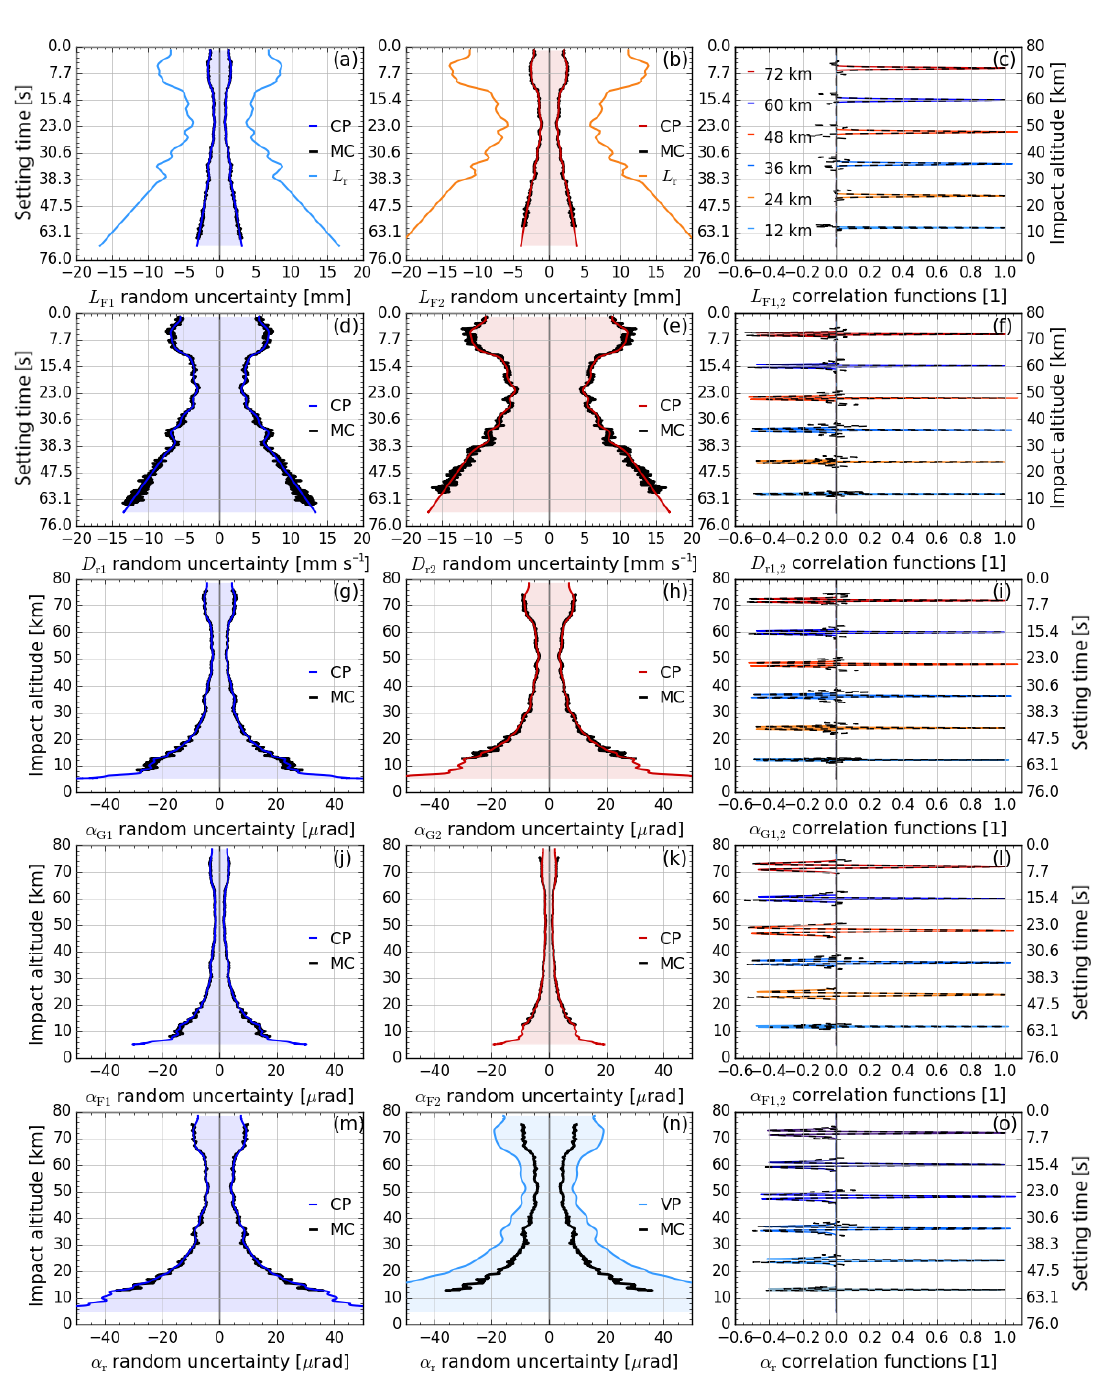
Figure 9. Results from the validation of CP covariance matrices C CP (“CP”) by MC covariance matrices C MC (“MC”) (first four rows): the L r L r consecutive retrieval steps are shown for L F ( a–c ; in panels a–b also for L r ) and D r (d–f) relative to setting time t , and for α G (g–i) and α F (j–l) relative to impact altitude z a . The left column shows estimated random uncertainties for f T1 (CP in blue, MC in black, in panel a u r in light blue); the middle column for f T2 (CP in red, MC in black, in panel b u r in orange); the right column representative correlation L r1 L r2 functions at 60, 36, and 12km for f T1 (CP in blue, MC in black) and 72, 48, and 24km for f T2 (CP in red, MC in black). The last row (m–o) shows CP (blue) and MC (black) results for estimated α r random uncertainties (m) and representative correlation functions at 72, 60, 48, 36, 24, and 13km (o) , as well as variance propagation (“VP”) results (light blue) for α r in panel (n)